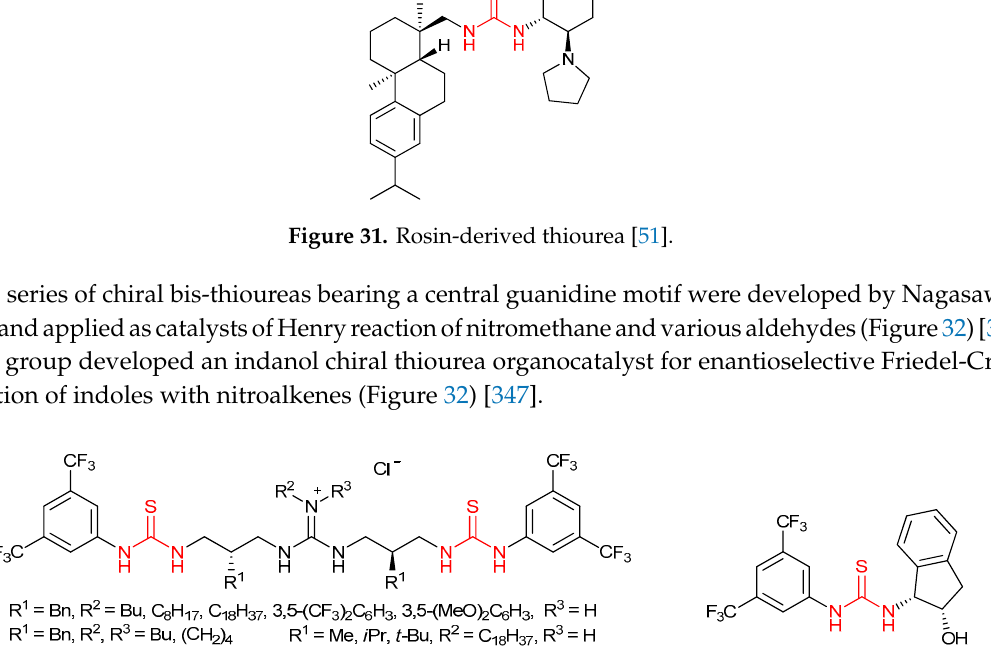
Figure 32. Chiral thioureas with guanidine moiety [346] and indanol derivative [347].